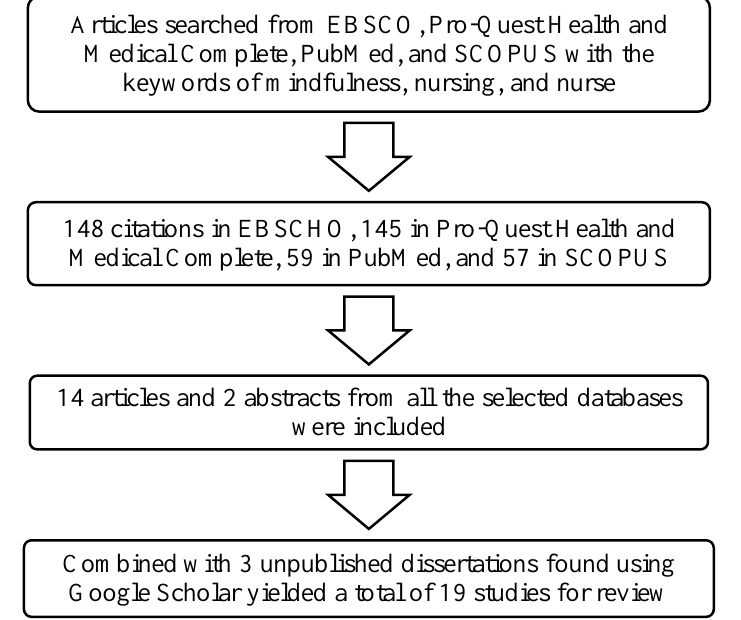
Figure 1: Flowchart of the reviewing